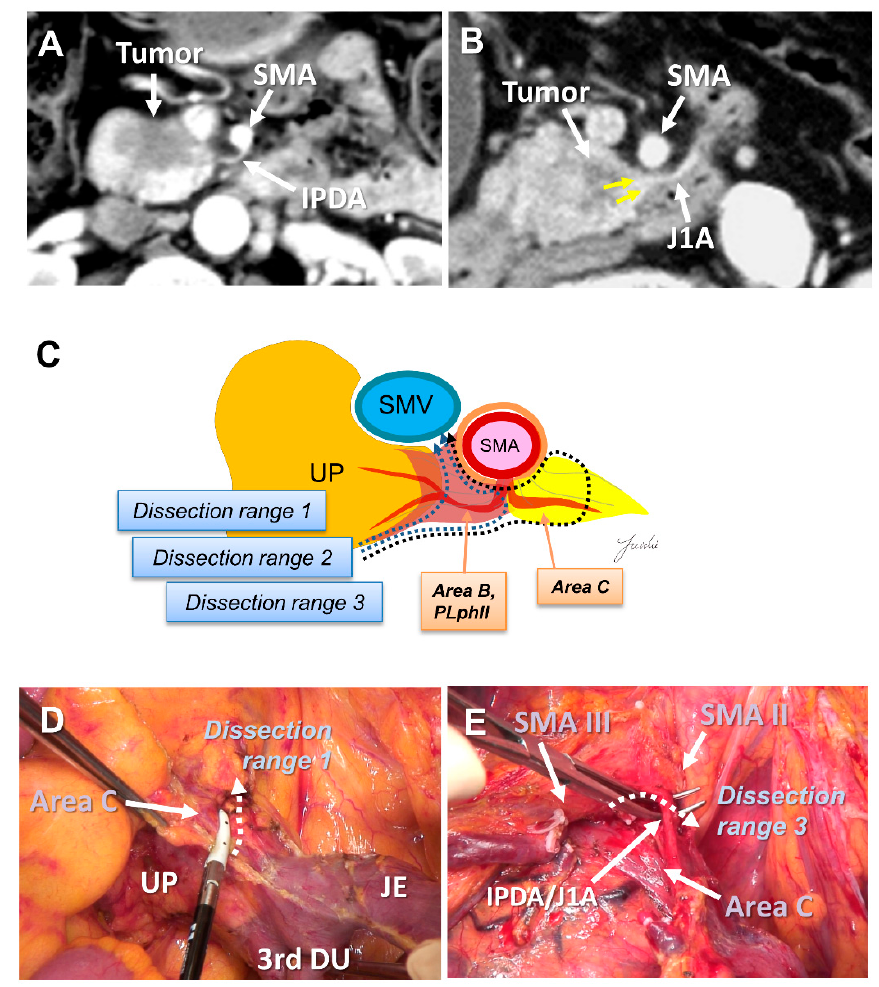
Figure 4. ( A ) Tumor extension to the SMA is not observed on the preoperative MDCT findings. ( B ) Tumor extension to the posterior side of the SMA is observed. ( C ) Determination of the dissection range based on the MDCT findings. Dissection ranges 1, 2, and 3 can be selected based on the anatomical structure, depending on the range of posterior infiltration. ( D ) Cutting line for dissection range 1. ( E ) Cutting line for dissection range 3. MDCT: multi-detector computed tomography; SMA: superior mesenteric artery; IPDA: inferior pancreaticoduodenal artery; J1A: first jejunal artery; UP: uncinate process; 3rd DU: third portion of duodenum; JE: jejunum.